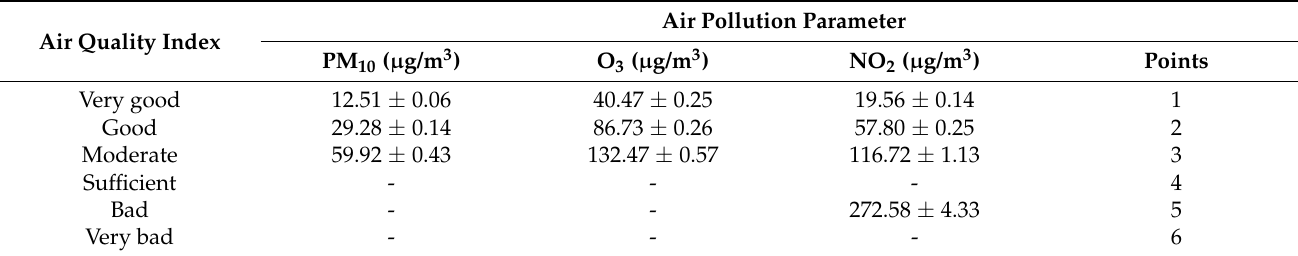
Table 2. Value of air pollution parameters for individual air quality categories (mean ±